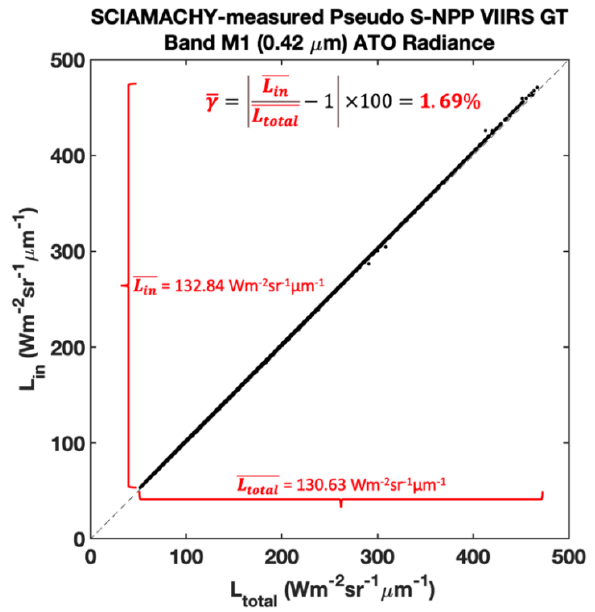
Figure 3. Notated scatter plot illustrating γ determination for an all-sky tropical ocean (ATO) scene. The ratio L in / L total can also be thought of as the slope of a pseudo radiance pairs linear regression that is forced through 0 Wm -2 sr -1 μm -1 .